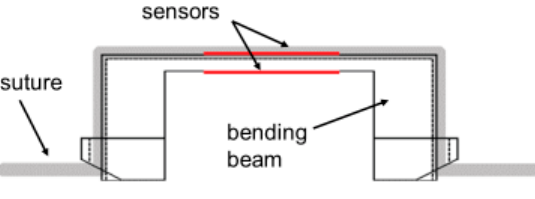
Figure 2. Schematic drawing of the sensor device.